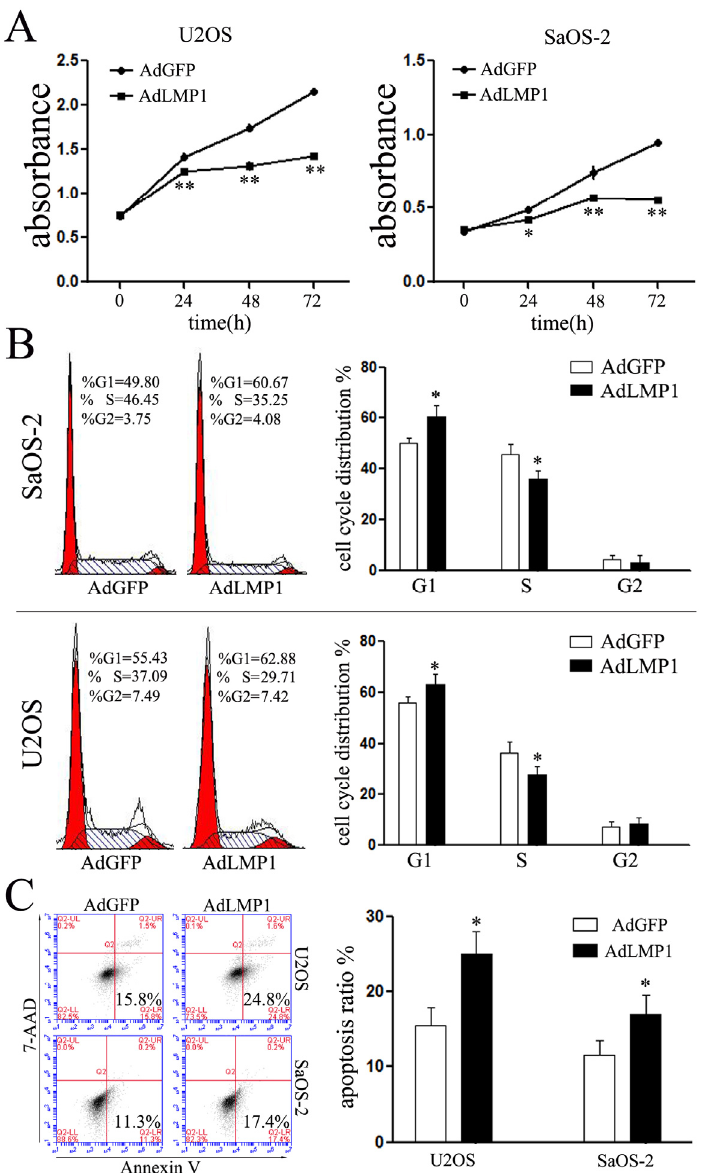
Figure 3. Overexpression of LMP-1 suppressed OS cell growth. ( A ) CCK-8 assays were performed to determine the effects of LMP-1 on OS cell proliferation. Overexpression of LMP-1 suppressed the cell proliferation of both OS cells; ( B ) Cell cycle analysis ( left ) and bar graphs ( right ) of U2OS and SaOS-2 cells by flow cytometry 48 h after transfection with LMP-1 adenovirus. Overexpression of LMP-1 arrested cell cycle progression in G1 phase; ( C ) Apoptosis measurements ( left ) and bar graphs ( right ) in U2OS and SaOS-2 cells treated with LMP-1 and GFP adenovirus. Ectopic expression of LMP-1 induced apoptosis of both cell lines. ** p < 0.01. * p <